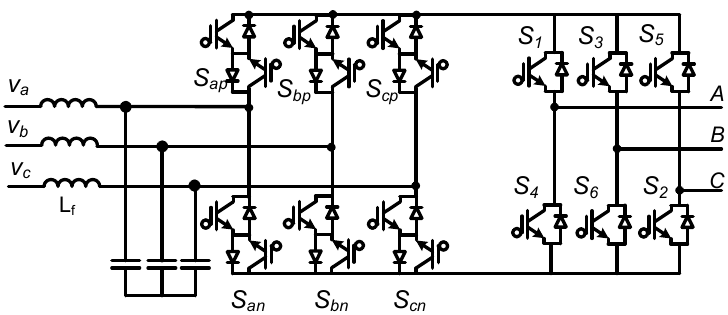
Figure 1. The conventional Indirect Matrix Converter topology.